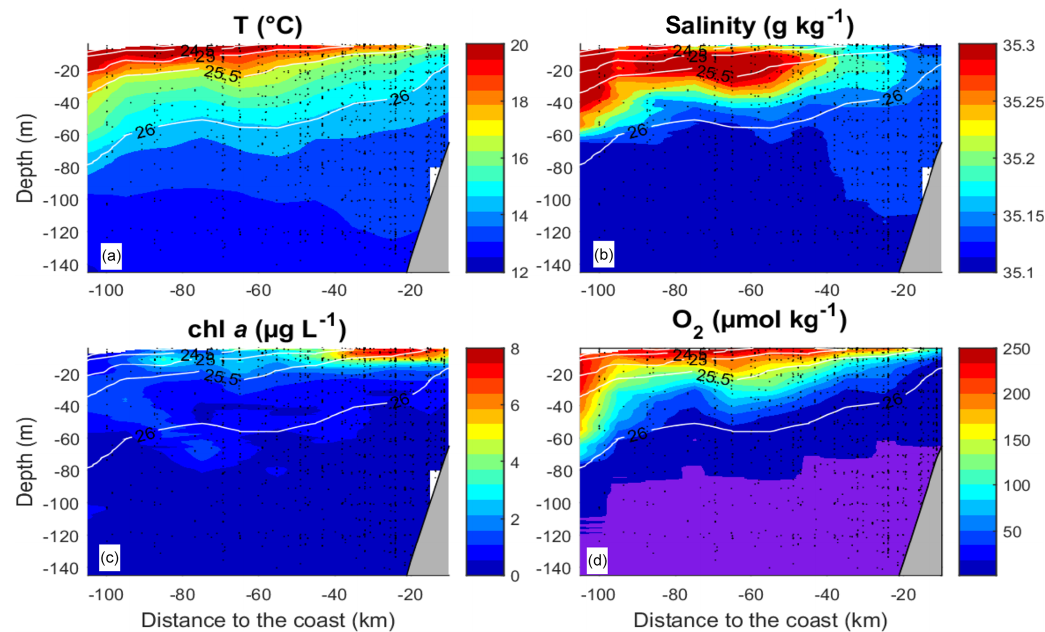
Figure 2. Mean vertical distribution of the temperature (a) , salinity (b) , (c) chlorophyll a (chl a ) and (d) O 2 . O 2 values below 1µmolkg − 1 are shaded in violet. The data from all transects and stations were averaged over intervals of 10km on the “Distance from the coast” axis and over 1m on the “Depth” axis. Isolines represent potential